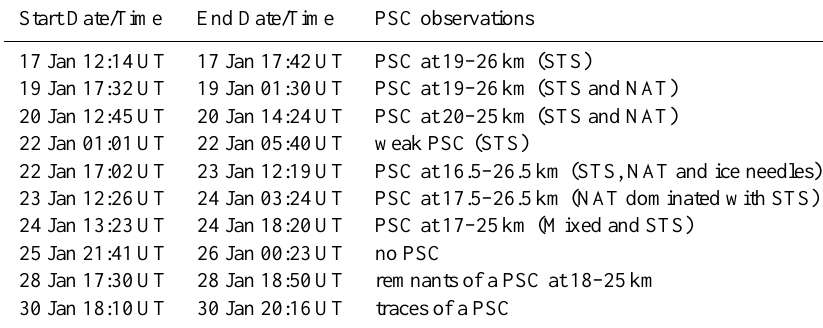
Table 1. PSC observations with the Esrange lidar during the campaign period 16 to 30 January